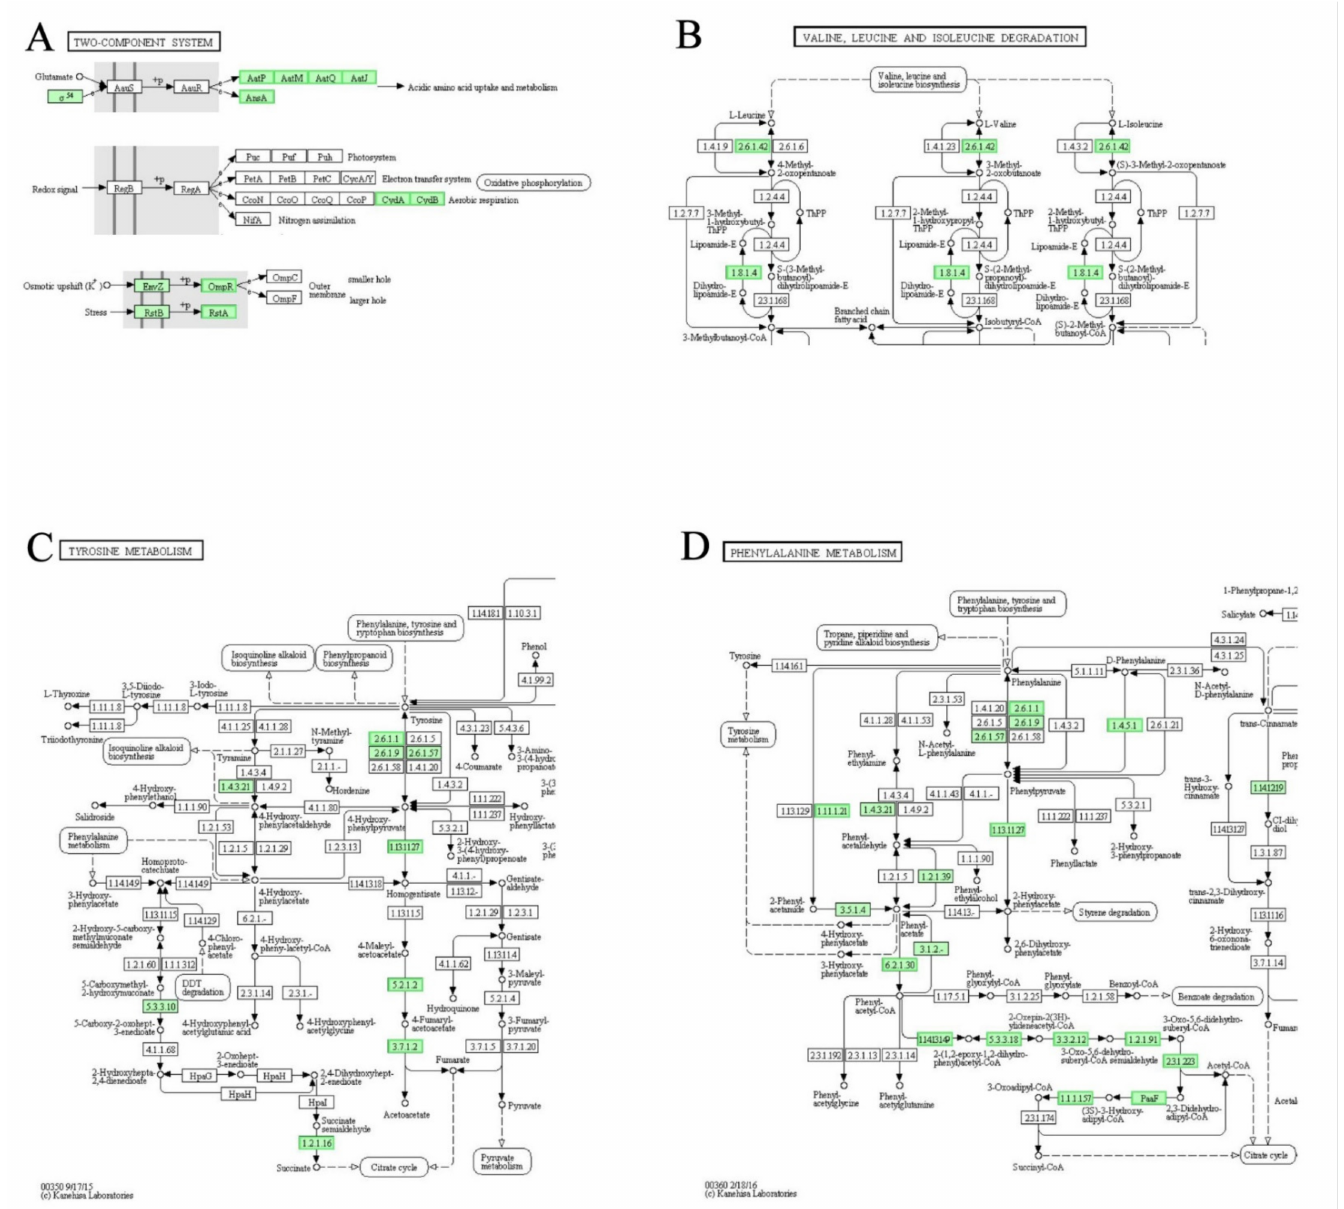
Figure 6. Significantly enriched KEGG pathway “Two-component system” ( A ), “Valine, leucine and isoleucine degra- dation” ( B ), “Tyrosine metabolism” ( C ) and “Phenylalanine metabolism” ( D ); (from KEGG database, green rectangles represent proved Organism-specific gene product and green frames represent down-regulation and red frames represent